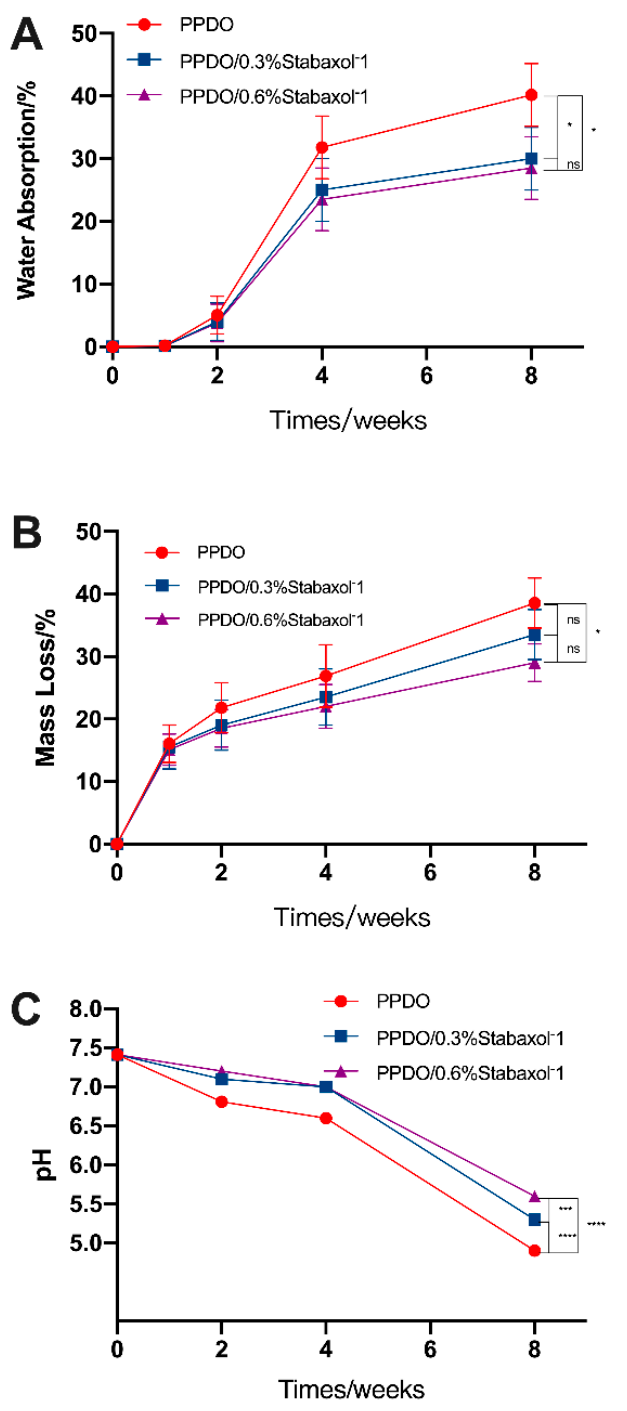
Figure 5. Hydrolysis degradation assays. ( A ) Water absorption was carried out exactly as described in the Materials and Methods section. Compared with PPDO, PPDO/0.3% stabaxol ® -1 and PPDO/0.6% stabaxol ® -1 showed lower water absorption after 8 weeks. ( B ) Mass loss was measured and calculated as described in the Materials and Methods section. The mass loss of the PPDO group declined obviously, while that of the PPDO/0.6% stabaxol ® -1 group decreased less; p value < 0.05, *. ( C ) pH monitoring during hydrolysis. pH value was taken and recorded at each time point. The pH value dropped sharply without stabaxol ® -1; p value < 0.001, ***, p value < 0.0001, ****.